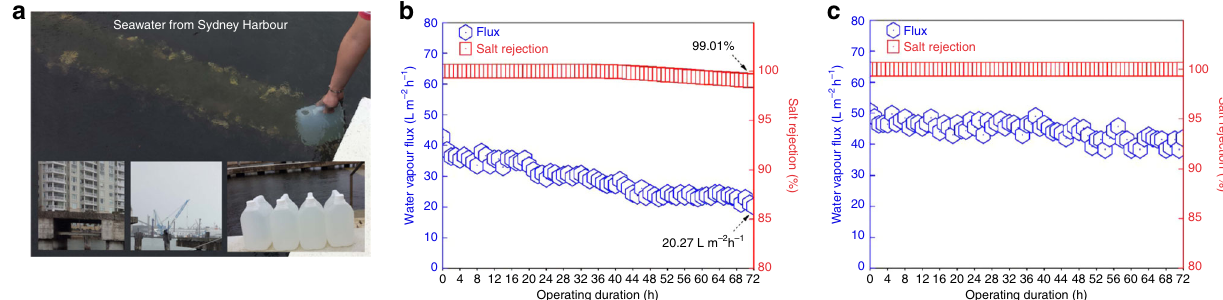
Fig. 6 Desalination of seawater from Sydney Harbour. a Photographs of the water extraction process and site. b , c Water vapour fl ux and salt rejection performances of b a commercial PTFE-based MD membrane and c the permeable graphene-based membrane in the DCMD process for 72 h. The feed and permeate temperatures were 60 and 20 °C, respectively. The fl ow rates of all DCMD tests were both maintained at 30 L h − 1 in the feed and permeate stream. Strong antifouling nature of permeable graphene fi lm with high and stable water vapour fl ux are demonstrated over a long operation time. Stable, 100% salt rejection rate is